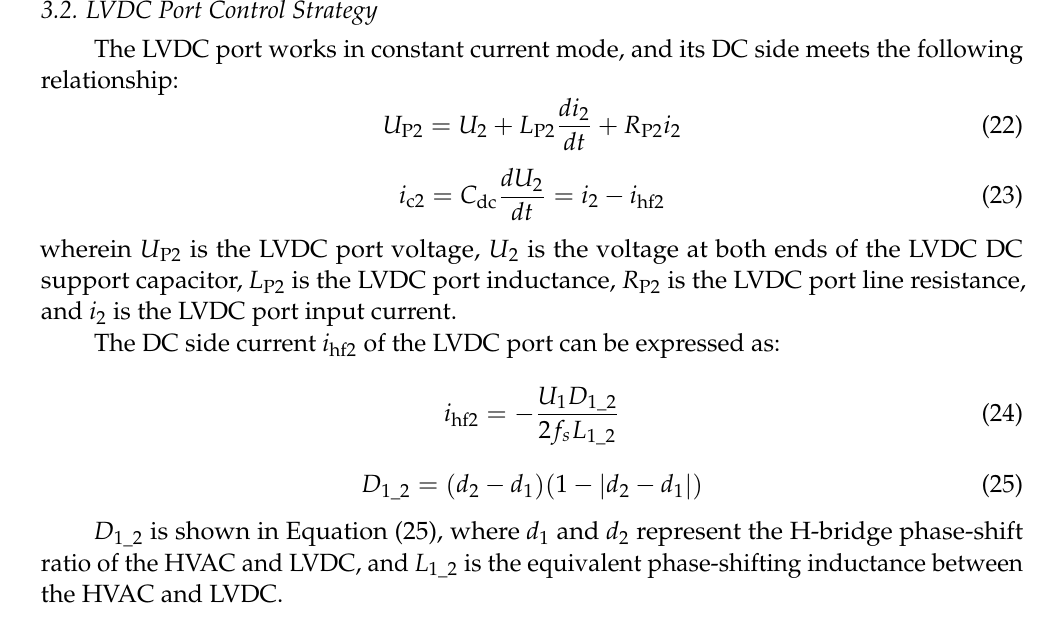
Figure 5. Average active power control block diagram of HVAC: ( a ) Three-phase total average active power control block diagram; ( b ) single-phase average active power control block diagram.